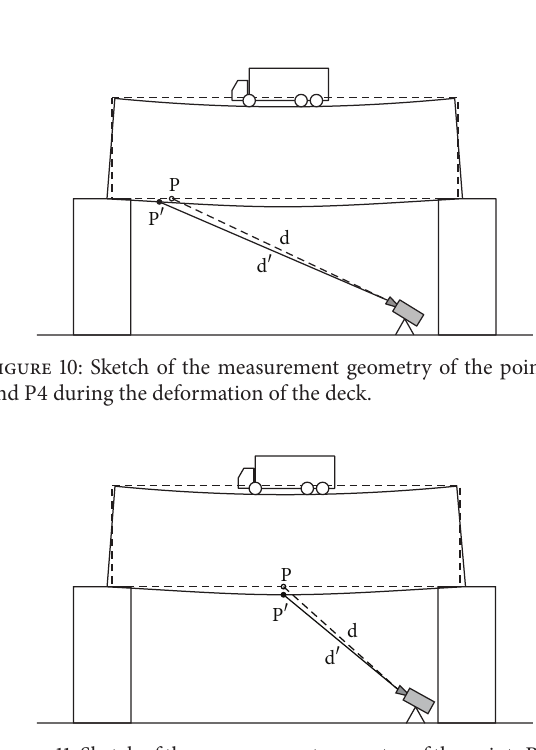
Figure 11: Sketch of the measurement geometry of the points P3 and P4 during the deformation of the deck.